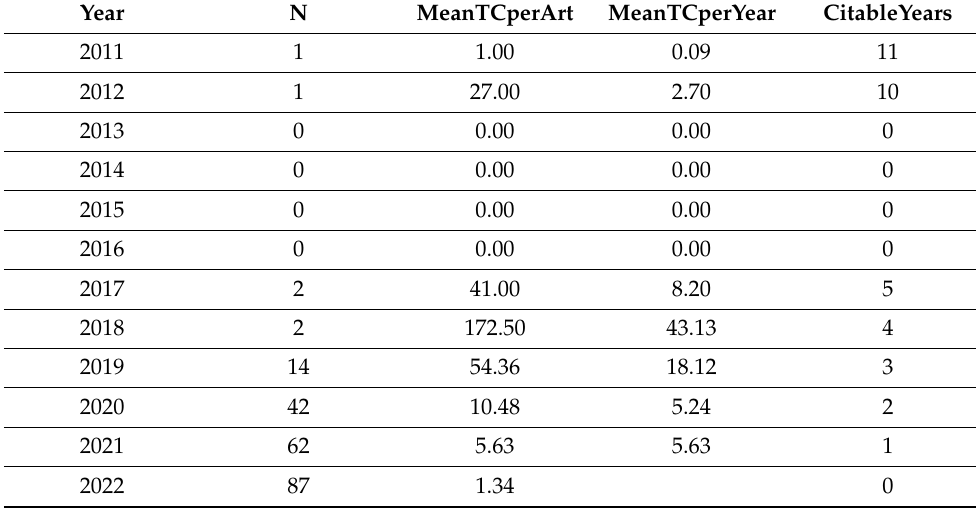
Table 2. Annual Citation Structure per year.